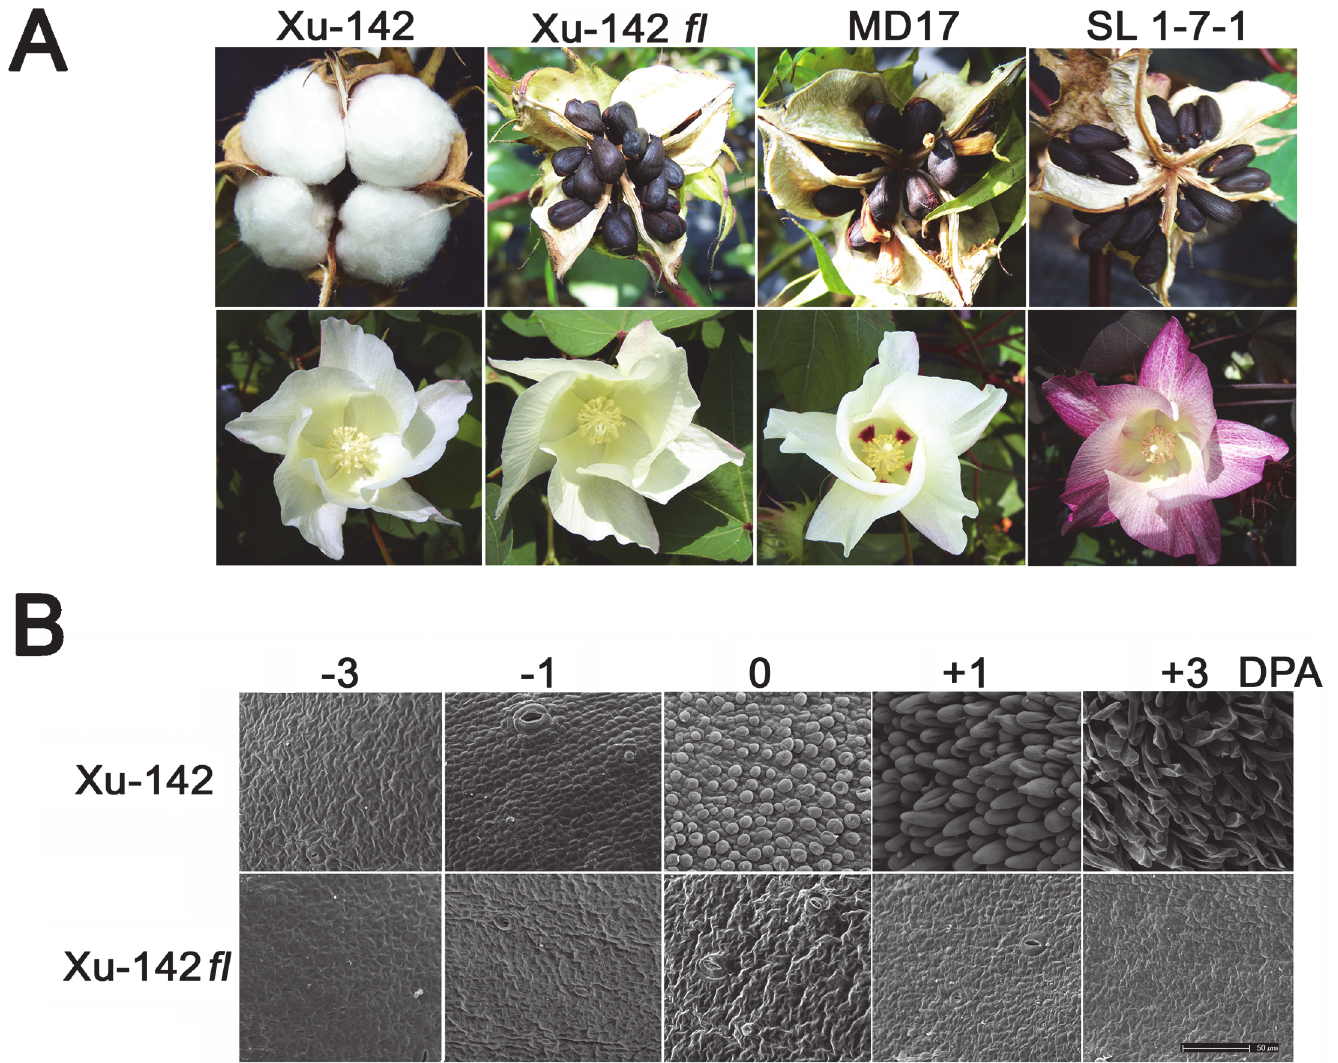
Fig 5. Phenotypic comparisons of a wild type and three different fiberless cotton mutants. A. Cotton bolls (top panel) and flowers (bottom panel) are from WT (Xu-142) and three fiberless mutants (Xu-142 fl , MD 17, and SL 1-7-1). B. SEM images of epidermal tissue from G . hirsutum WT Xu-142 ovules (top panel) and fiberless Xu-142 fl mutant ovules (bottom panel). The ovules were harvested around 0900 on -3, -1, 0, +1, and +3 DPA. The bar represents the length of 50 μ